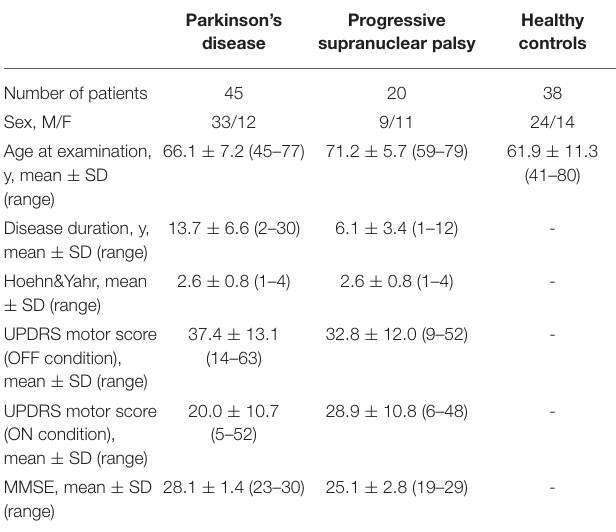
TABLE 1 | Demographic and clinical characteristics of study